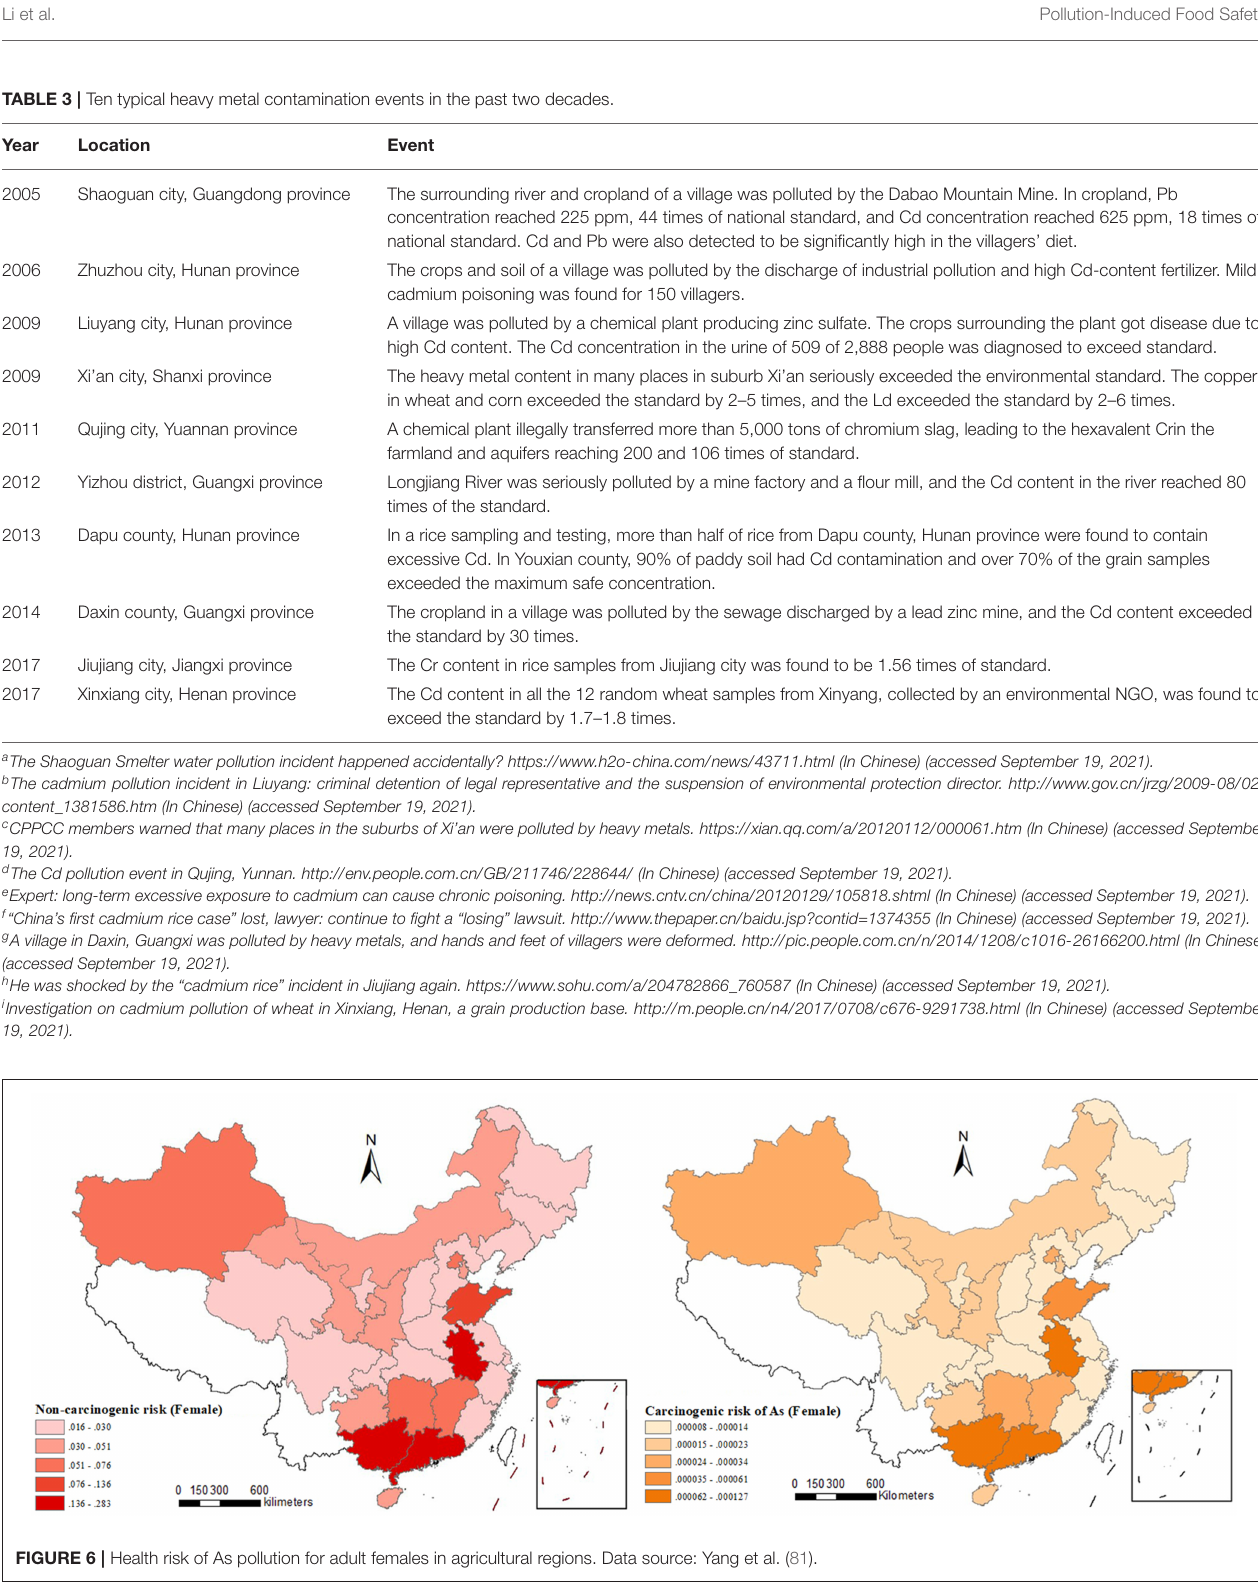
in some sewage irrigated areas. Accordingly, almost every surveyed area has pollutants exceeding the National Food Safety Standards (GB